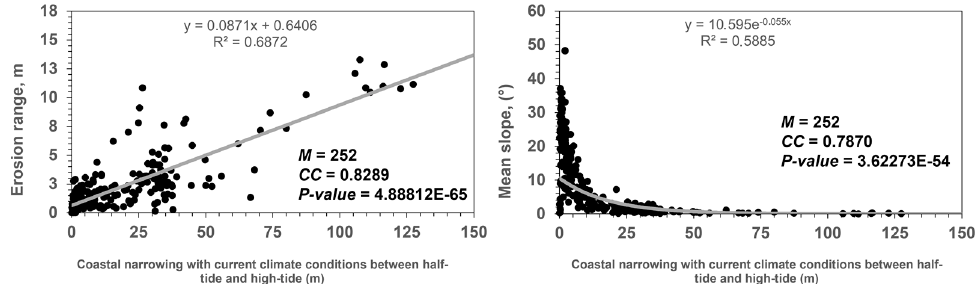
Figure 8. Correlation between coastal narrowing and erosion range ( left , linear trend), and mean slope ( right , exponential trend). M = sample; CC = correlation coefficient.